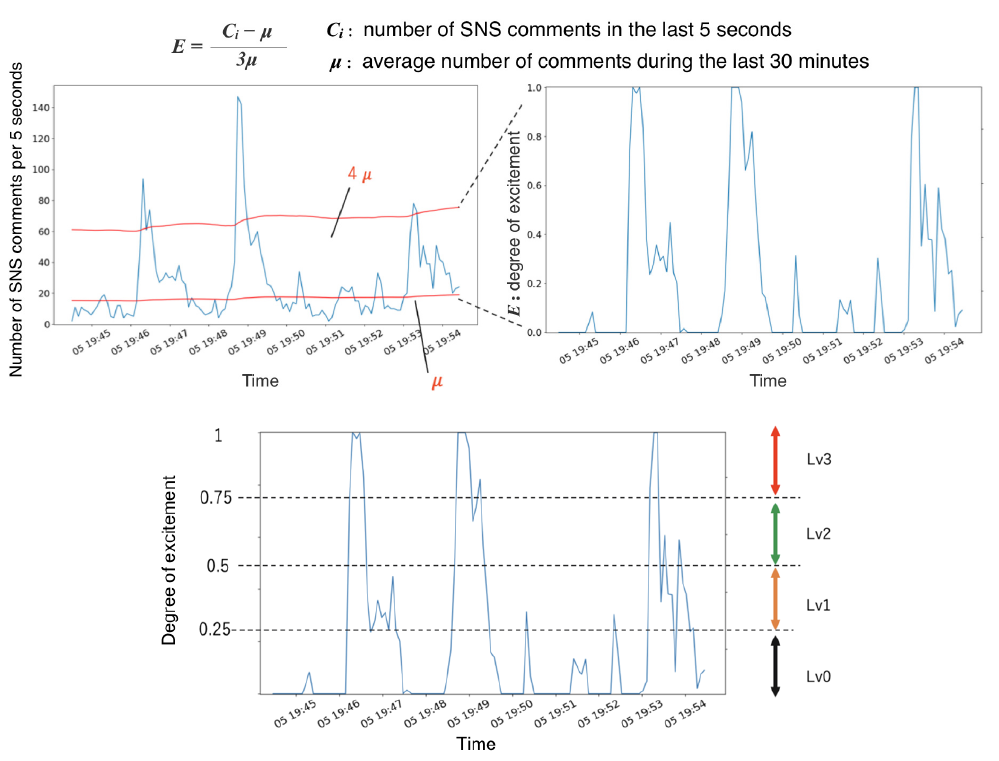
Figure 2. An example of a transition in the number of SNS comments and output of our model (upper image), and excitement variations during a television program sorted into levels (lower